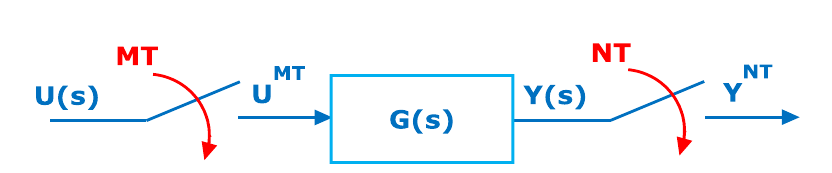
Figure 1. An initial MR